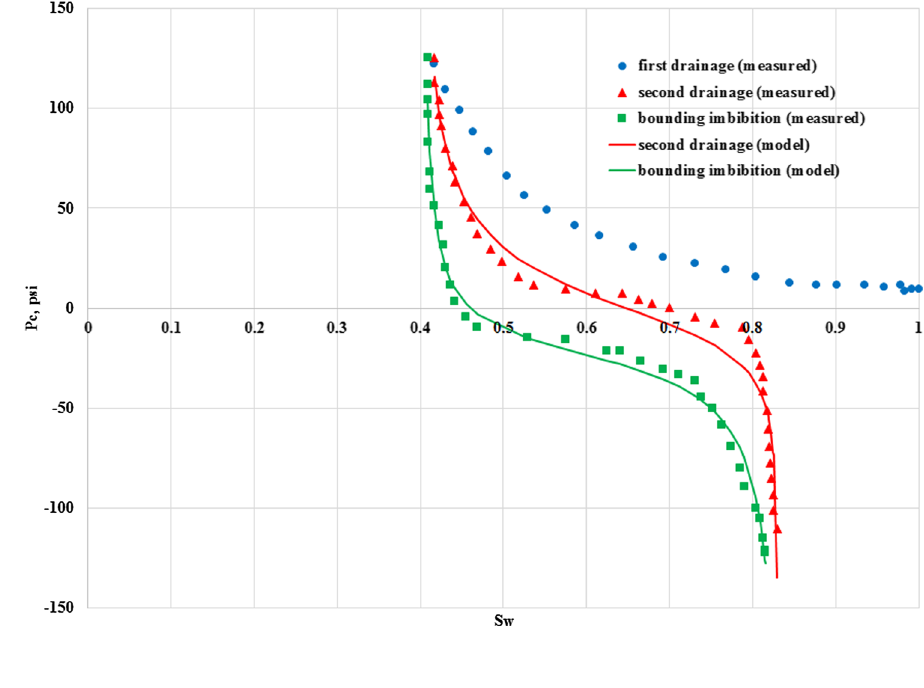
Fig. 8 Curve fitting of bounding imbibition and secondary drainage P c for